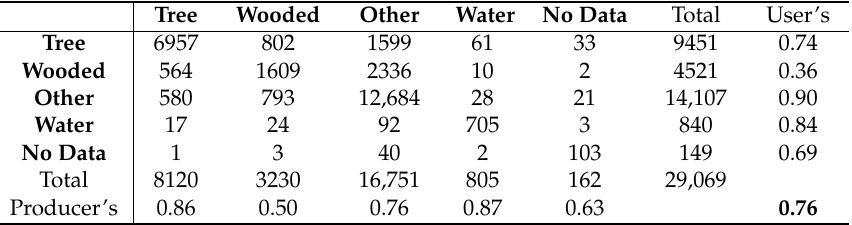
Table 3. Confusion matrix between land cover classes before and after expert review and revision for a sample of year 2000 sites. Figures are based on area in each class (thousands of hectares). Automatically mapped class labels are on left-hand side and the expert reviewed and revised labels are across the top of the table. Tree = tree cover, Wooded = other wooded land, Other = other land cover.